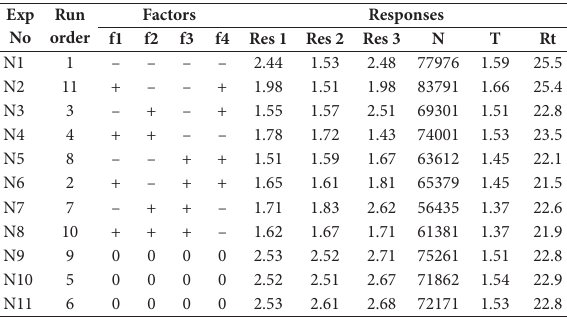
Table 4. Randomized 2 4–1 fractional factorial design and results of observed responses.